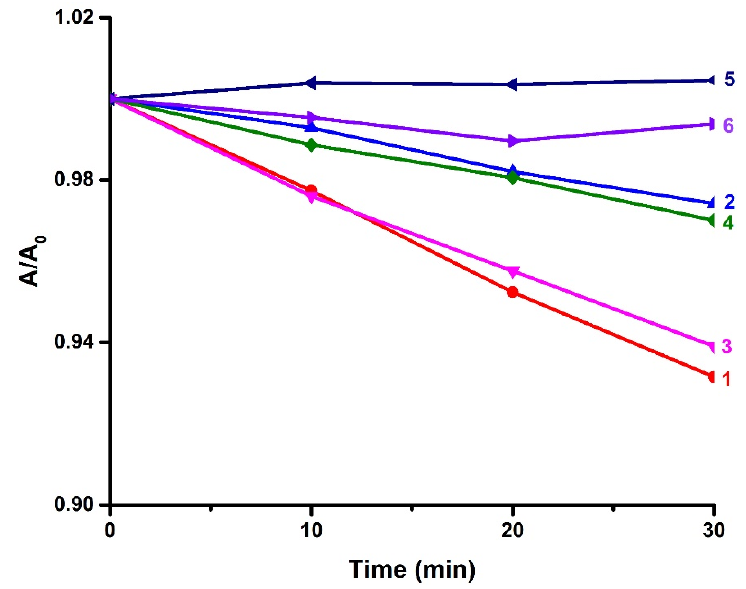
Figure 6. Photolysis kinetics of PI/TEOA systems upon LED@375 nm irradiation in acetonitrile ( 1 ) BPC1 / TEOA, ( 2 ) BPC2 / TEOA, ( 3 ) BPC3 / TEOA, ( 4 ) BPC4 / TEOA, ( 5 ) C5 / TEOA, ( 6 ) C7 / TEOA. ( A 0 absorbance of maximum wavelength at 0 min, A absorbance of maximum wavelength at t min.).